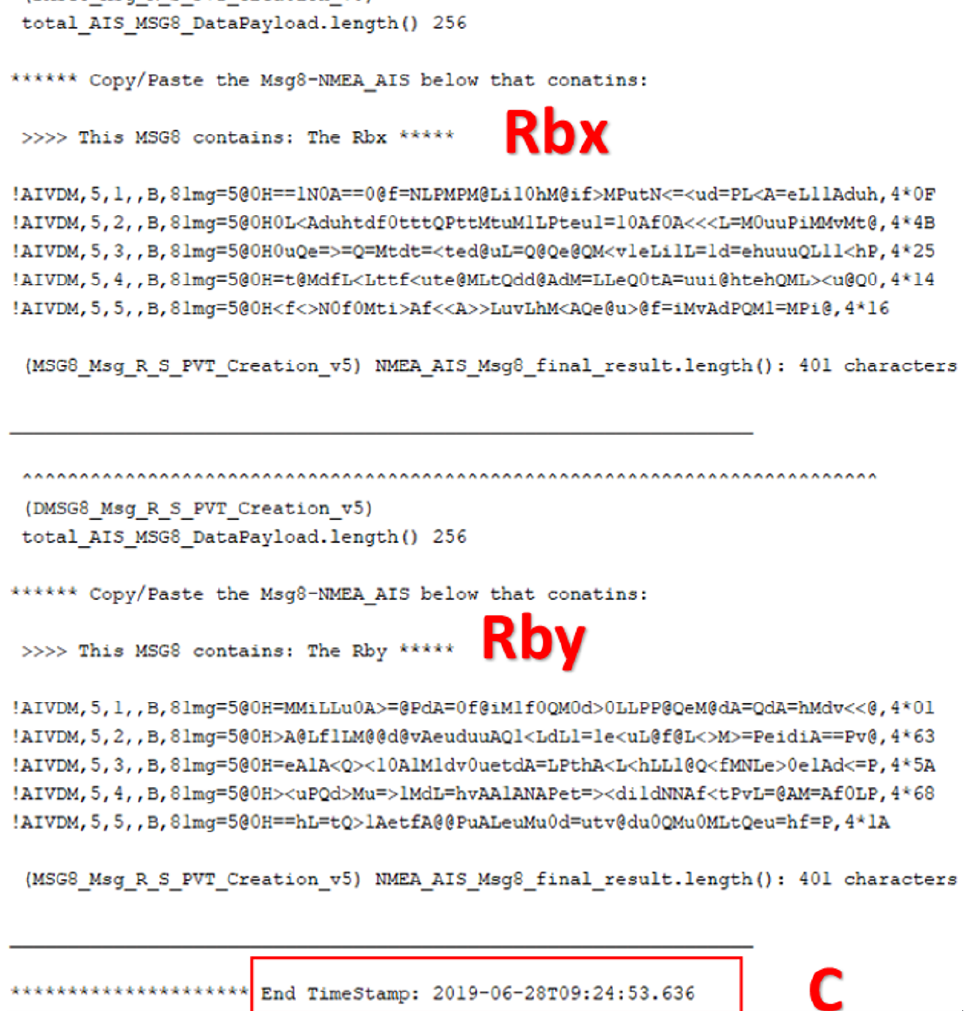
Figure 13. Creation of the three conventional ID8 AIS messages containing the H, Rx, and Ry cryptographic